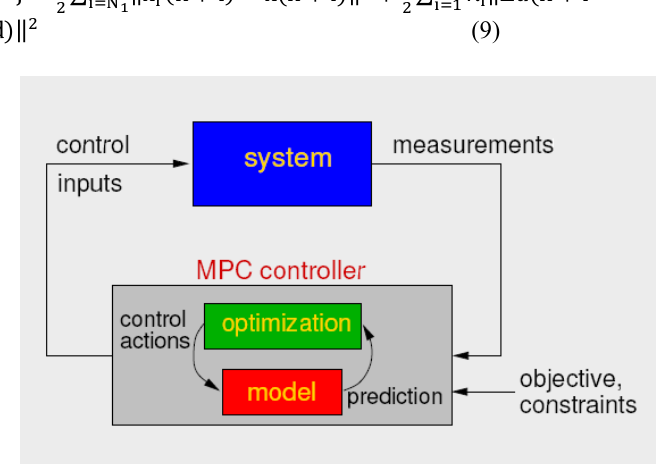
Fig. 5. Connection between MPC controller and the system